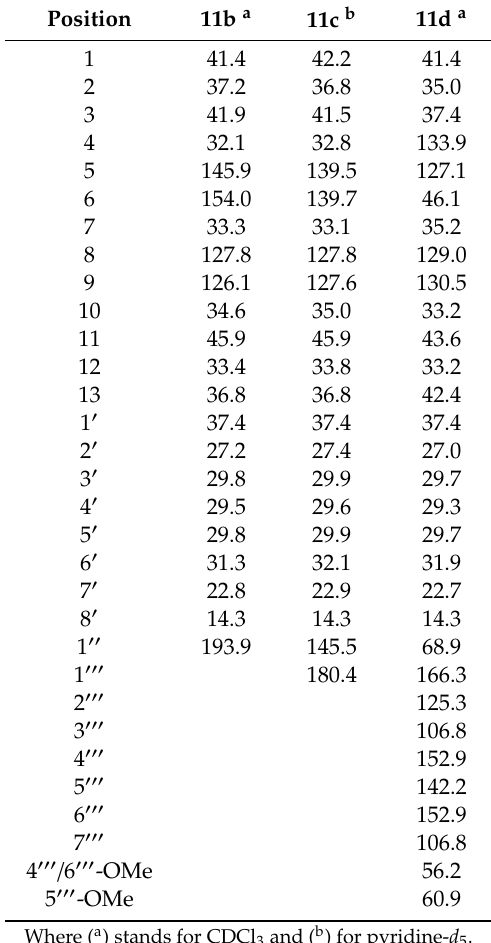
Table 2. 13 C–NMR (100 MHz) data of compounds, 11b , 11c , and 11d in CDCl 3 and pyridine- d 5